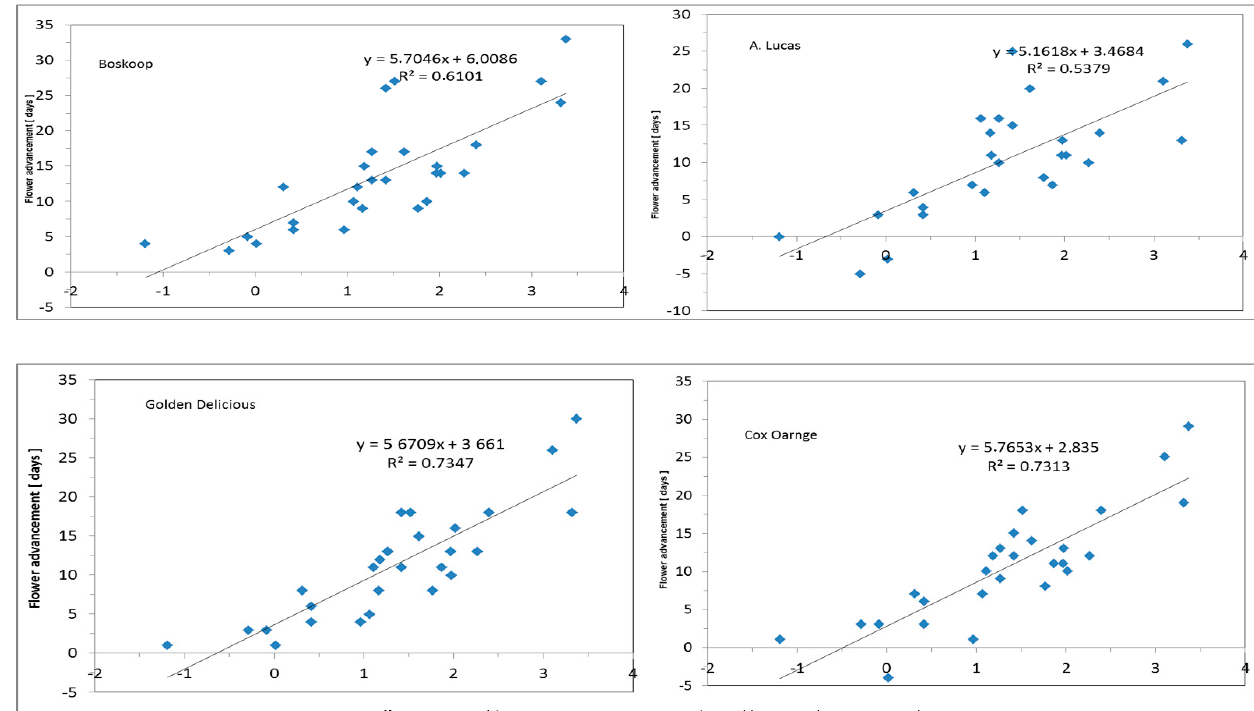
Figure 2. Correlations between flowering advancement in apple cv. Boskoop ( top left ), Golden Delicious ( bottom left ), Cox Orange ( Bottom right ) and pear ( top right ) and monthly temperature increase in March and April (with R 2 ) comparing phase II with phase I.